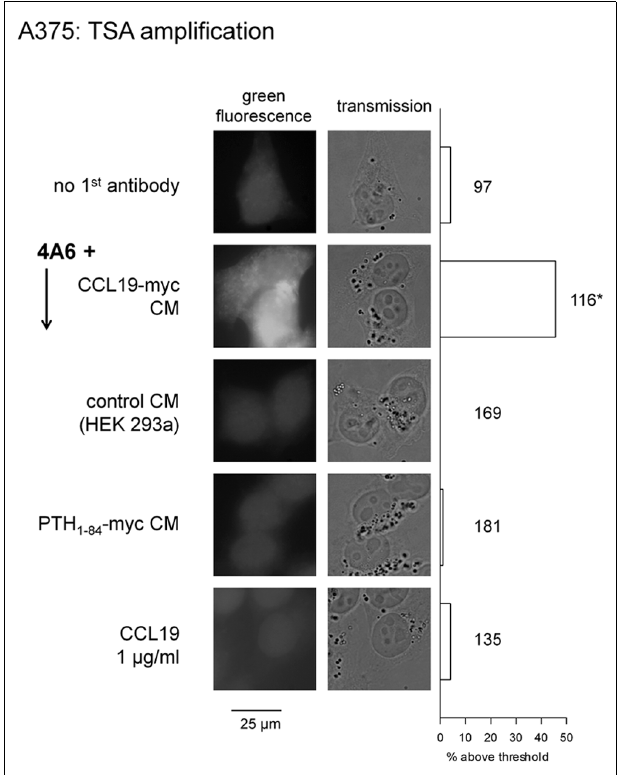
FIGURE 9 | Detection of endogenous CCR7 inA375 cells using detection of the endocytosed CCL19-myc-4A6 antibody complex using theTyramide SignalAmplification (TSA) system that enzymatically generatesAlexaFluor-488 labeling. Epifluorescence and transmission, original magnification: × 1000. Right: proportion of cells with a mean fluorescence intensity above a set threshold (Photoshop level ≥ 50/255) in large photographic records of A375 cells stained as in the left of figure (the number of evaluated cells is indicated next to each histogram).The proportions were compared with that of control cells without antibody (top-most histogram, χ 2 test; * p < 10 − 4